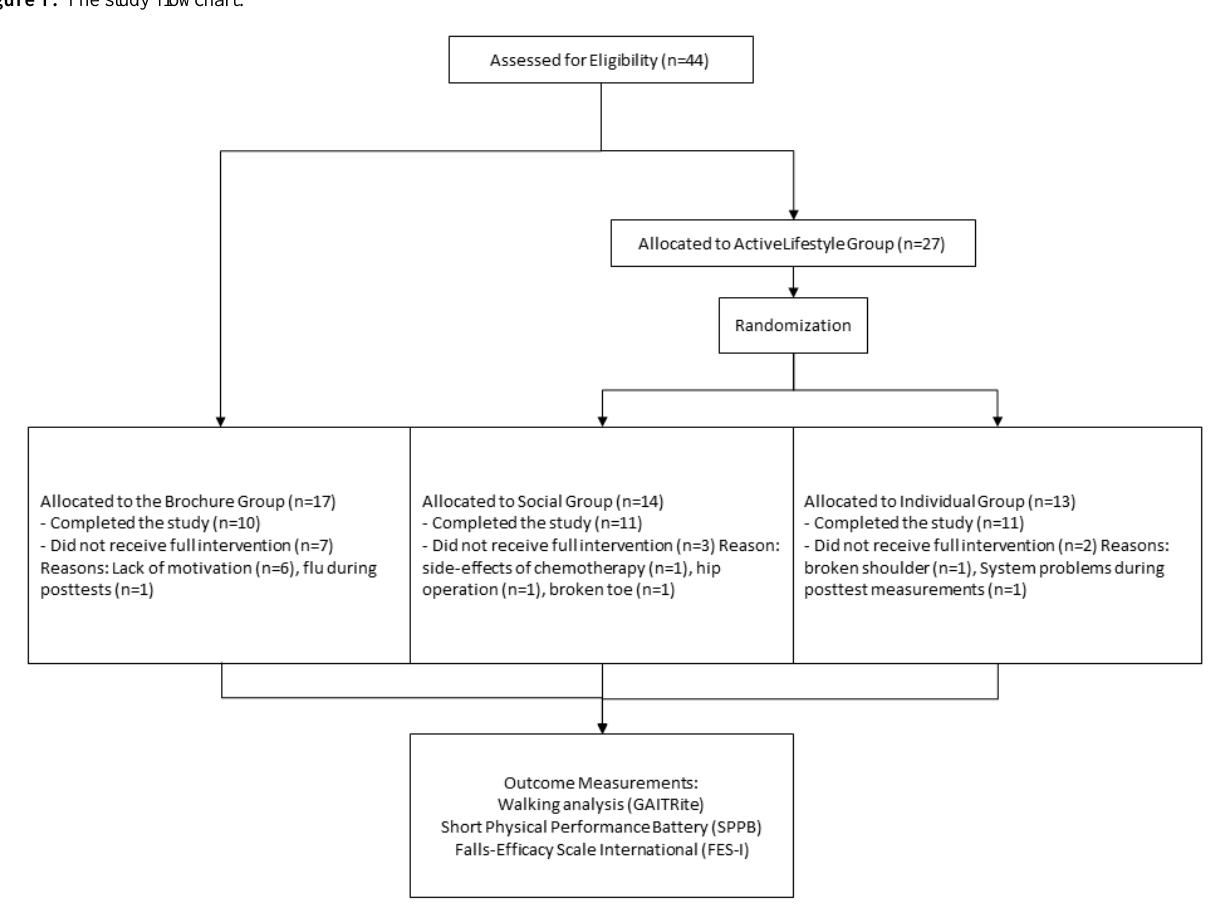
Figure 1. The study